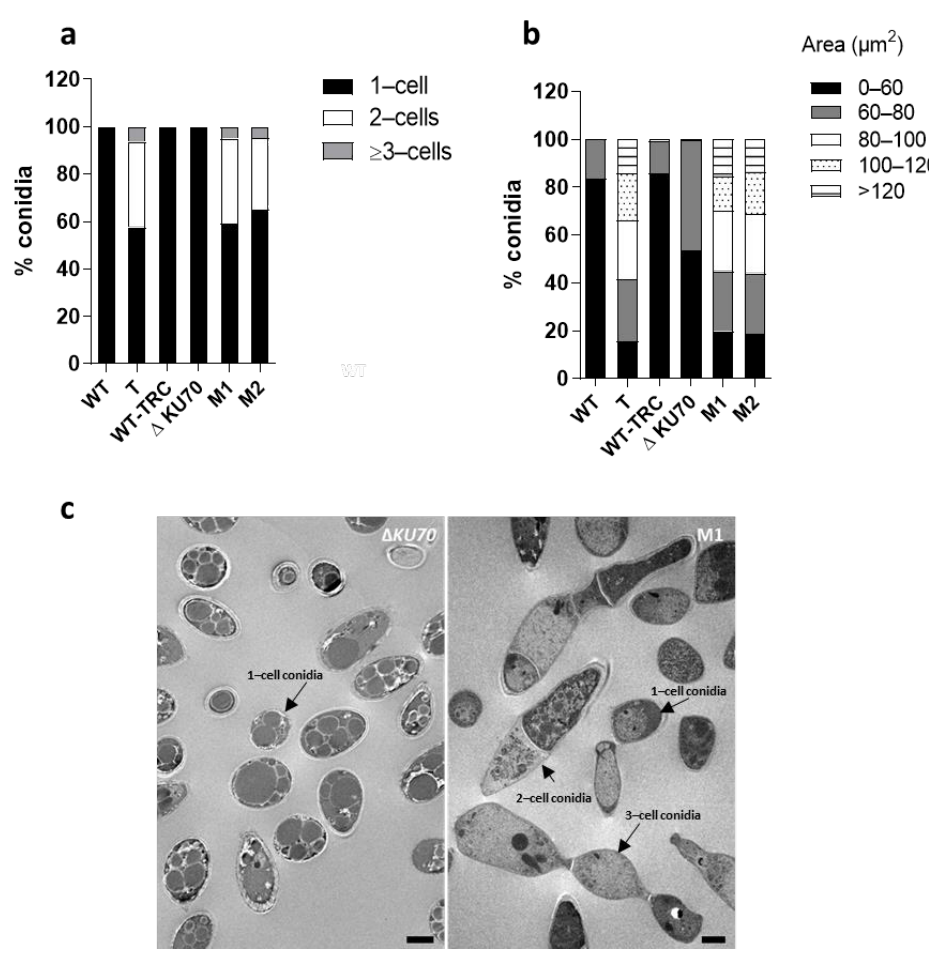
Figure 6. Morphology of conidia. ( a ) Distribution of conidia morphotypes. At least 200 conidia were measured. ( b ) Distribution of conidia sizes according to cross-sectional area. At least 200 conidia were measured from images of conidia suspensions acquired with a widefield inverted fluorescence microscope (Olympus IX71) at 20× magnification and analyzed using ImageJ (Fiji) software. ( c ) Transmission electron microscopy (TEM) of ∆ KU70 and M1 conidia. Images are representative of the three transformants. Scale bar: 2 µm. T: transformant derived from the WT strain; M1 and M2: transformants derived from the Δ KU70 strain.